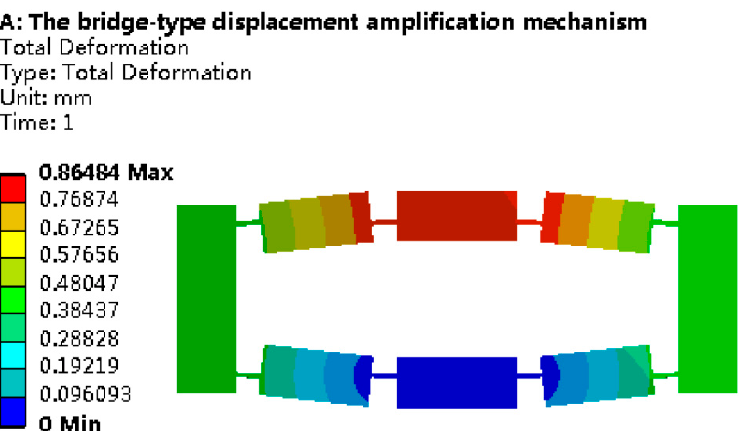
Figure 3. The deformation results of the bridge-type displacement amplification mechanism.